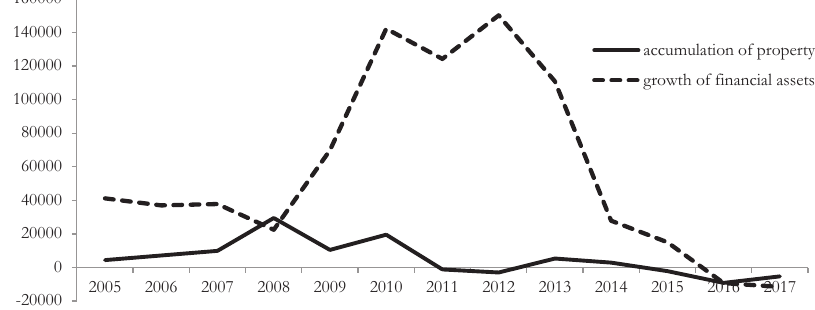
Fig. 1 – Dynamics of the variable elements of household expenditures in 2001-2017. Source: own research In the classical economic theory. the default assumption is that asset allocation decisions of households are driven by expectations regarding returns and liquidity. We evaluate the extent to which this holds true for Ukrainian households by using the correlation